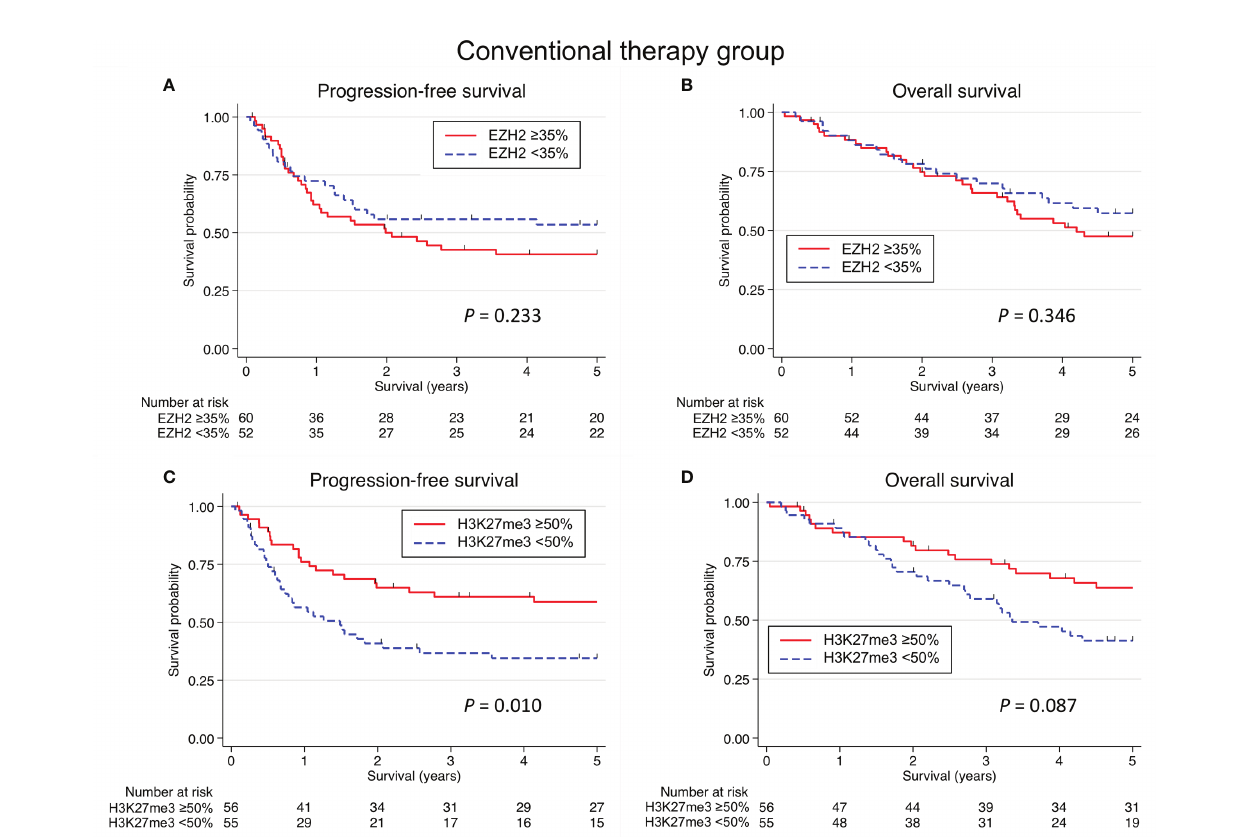
FIGURE 3 | Kaplan-Meier survival curves according to the EZH2/H3K27me3 expression in salivary duct carcinoma with conventional therapy. No signi fi cant association was identi fi ed between the EZH2 expression and the progression-free survival (PFS) (A) or overall survival (OS) (B) . (C) A low expression of H3K27me3 was associated with a signi fi cantly shorter PFS ( P = 0.010), but there was no signi fi cant association between the H3K27me3 expression and the PFS in multivariate analysis. (D) Although a low expression of H3K27me3 tented to be associated with a shorter OS ( P = 0.087), no signi fi cant relation between the H3K27me3 expression and the OS was detected in univariate and multivariate